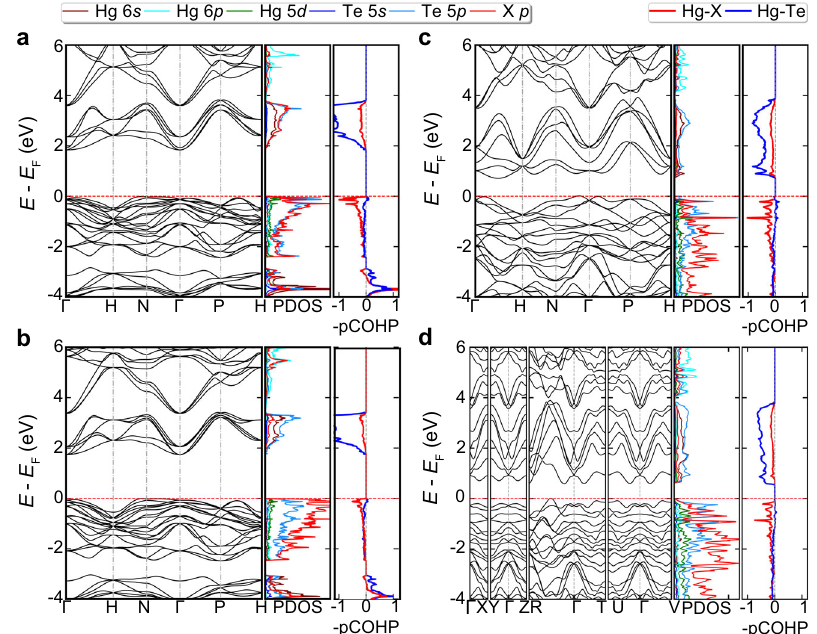
Fig. 4 Electronic structures of Hg 3 Te 2 X 2 under pressure. a Band structures, density of states (DOS), and -pCOHP of I 2 1 3 phase of Hg 3 Te 2 Cl 2 at ambient pressure. b I 2 1 3 phase of Hg 3 Te 2 Br 2 at ambient pressure. c I 2 1 3 phase (hypothetical) of Hg 3 Te 2 Cl 2 at 20 GPa. d R 3 phase of Hg 3 Te 2 Cl 2 at 20 GPa. Positive and negative -pCOHP indicates bonding and antibonding interactions, respectively.